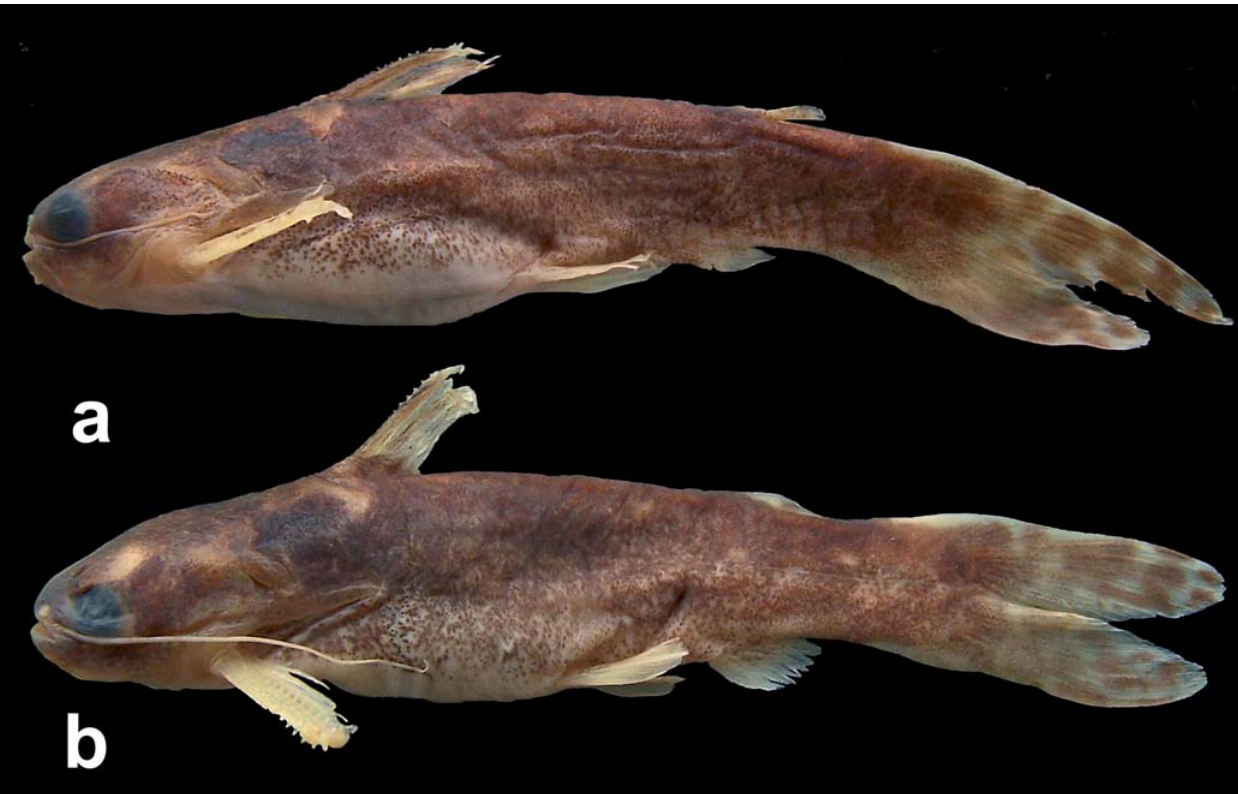
Fig. 33. Tatia neivai . (a) MHNG 2355.92, male, 51.6 mm SL. (b) MHNG 2355.92, female, 53.3 mm SL, Yuguyry stream,